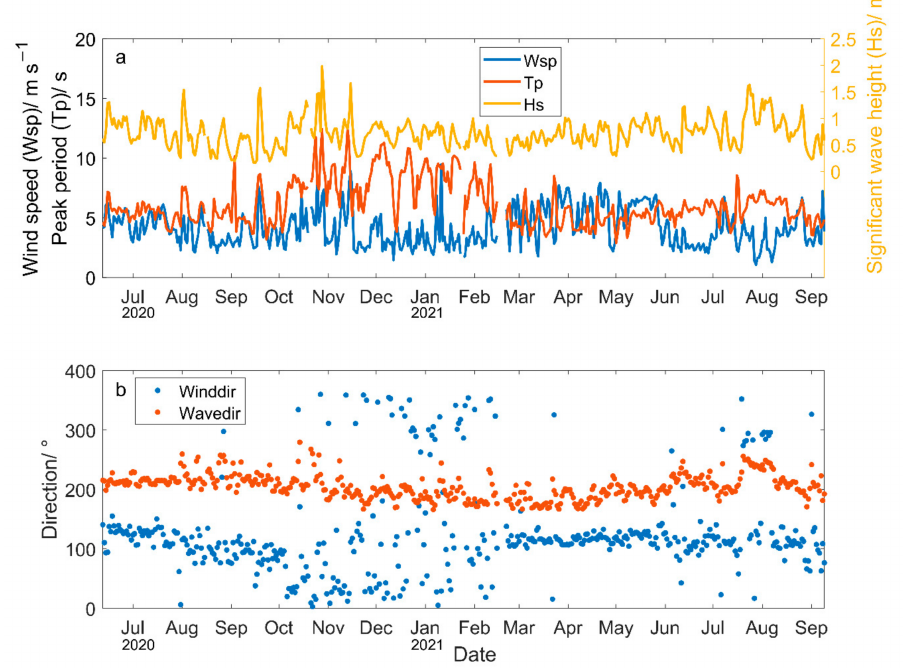
Figure 2. Daily series of the wind speed ( Wsp ), peak wave period ( Tp ), and significant wave height ( Hs ) ( a ) and mean wind/wave directions ( b